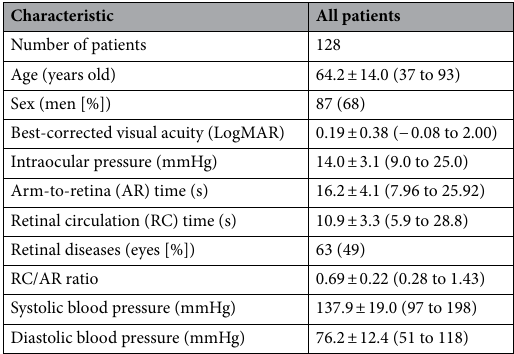
Table 1. Characteristics of the patients. Data are shown in mean ± standard error (range). AR time arm-to- retina time, RC time retinal circulation time, RC/AR ratio RC time/AR time